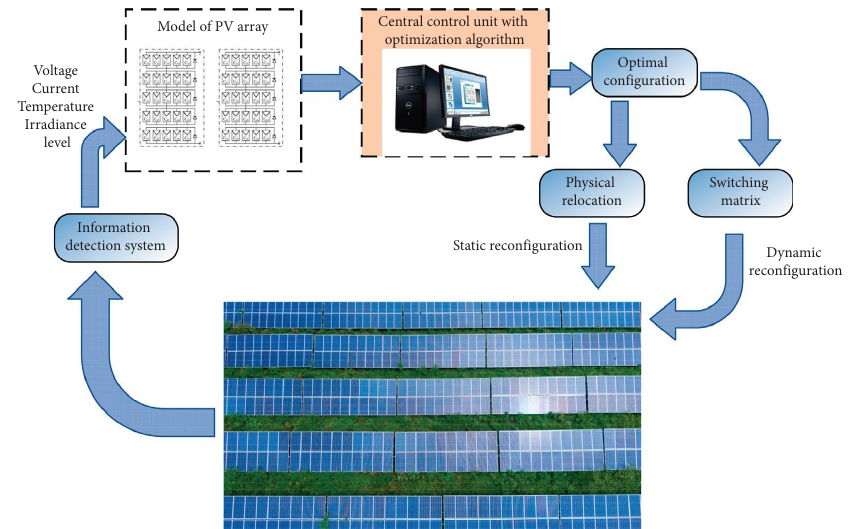
Figure 2: Structure of the reconfguration technique.